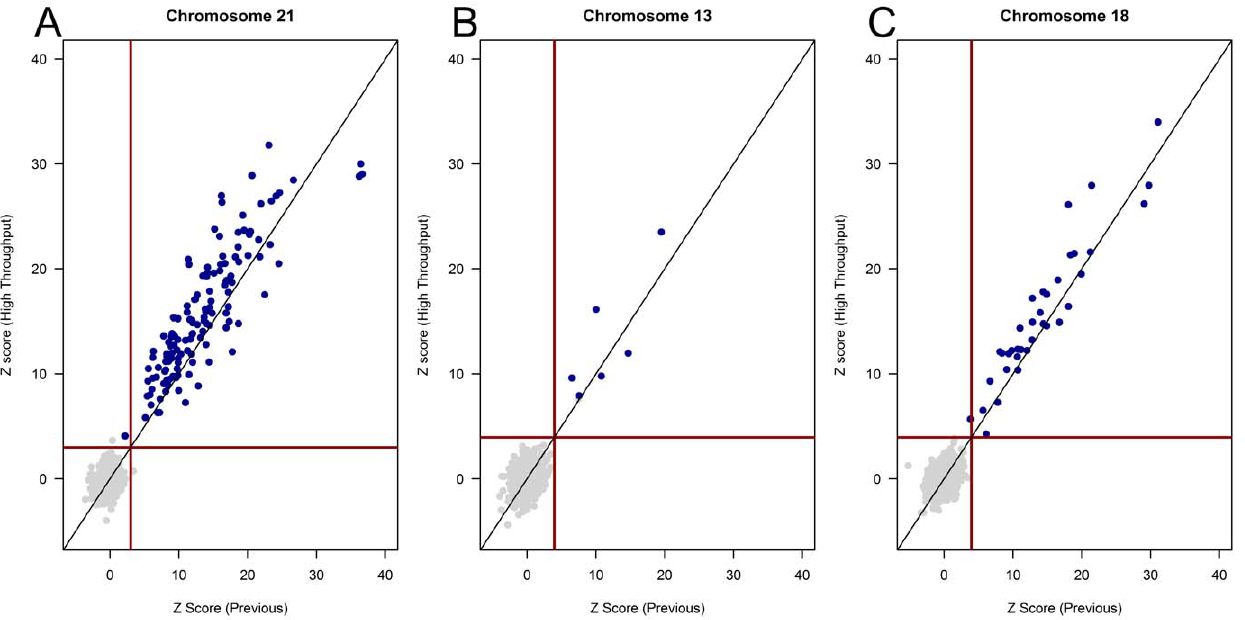
Figure 4. Paired comparison of z-scores. Z-scores were calculated for 1269 paired samples with previously described GC normalized, repeat masked z-scores on the x-axis [7] and z-scores from the high-throughput assay on the y-axis. Samples classified by karyotype analysis as trisomies for A) Chromsome 21, B) Chromosome 13, or C) Chromosome 18 are shown in blue; unaffected samples for each aneuploidy condition are shown in gray. Red horizontal and vertical lines in each plot represent the respective classification cutoff for that chromosome (z=3 for chromosome 21, z=3.95 for chromosomes 13 and 18). Black line in plot represents y=x. (Figure S1B) [5]. Finally, the median number of aligned autosomal reads per sample was 16,291,390 (range: 8,825,886–35,259,563) (Figure S1C).